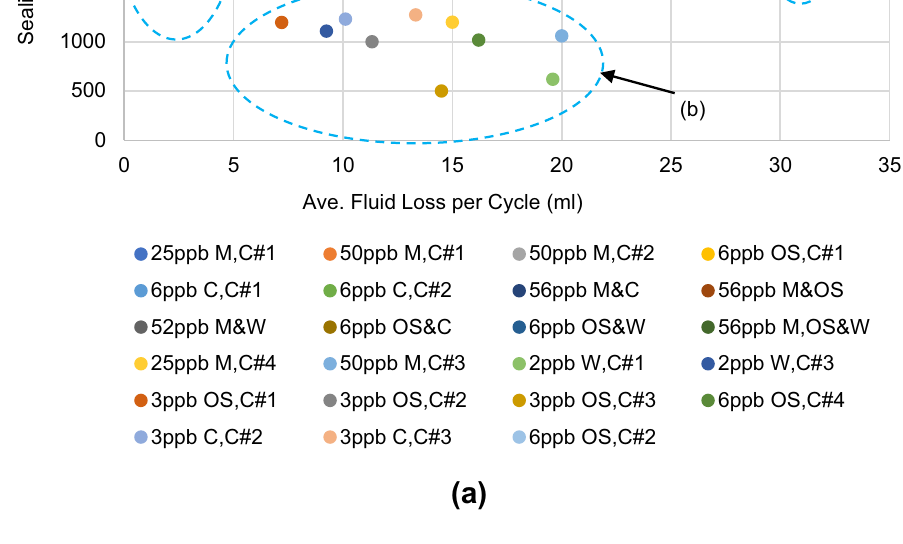
Fig. 33 Overall Performance of LCM using 1 mm & 2 mm cell (C1 & C2). a Higher seal- ing pressures were observed at lower fluid loss values < 5 ml at small fracture widths. b Screen out at the fracture mouth cased higher fluid loss. c Lower seal integrity with relatively higher fluid loss value for one test. d High sealing pressures in conjunction with low fluid loss values due to the wide range of PSD. e Moderate sealing pressure and fluid loss